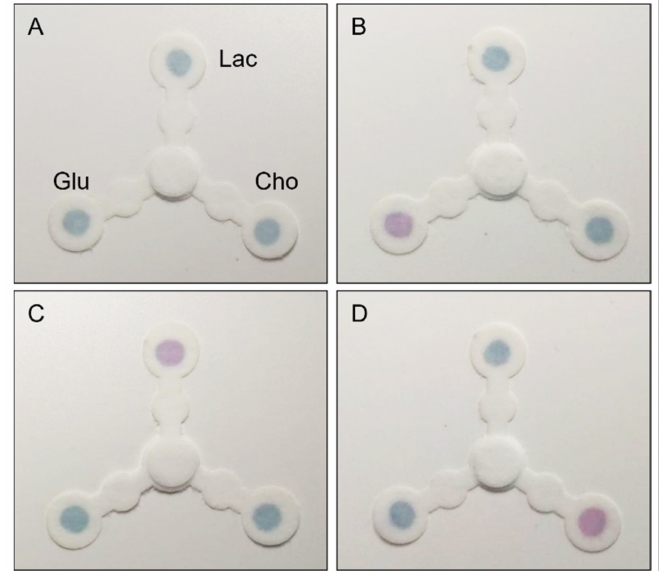
Figure 4. Representative photographs of the multiplexed devices after 10 min of reaction, treated with ( A ) native saliva, ( B ) saliva spiked with glucose (Glu) (14 µ M), ( C ) saliva spiked with lactate (Lac) (2 mM) and ( D ) saliva spiked with cholesterol (Cho) (5.2 µ M).